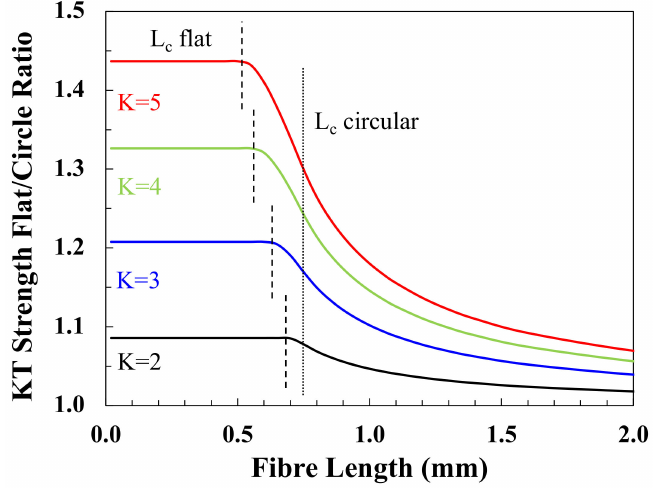
Figure 6. Kelly–Tyson equation prediction of flat/circular strength contribution ratio in unidirectional discontinuous GF-PP composites for fibre with different flatness ratios ( K